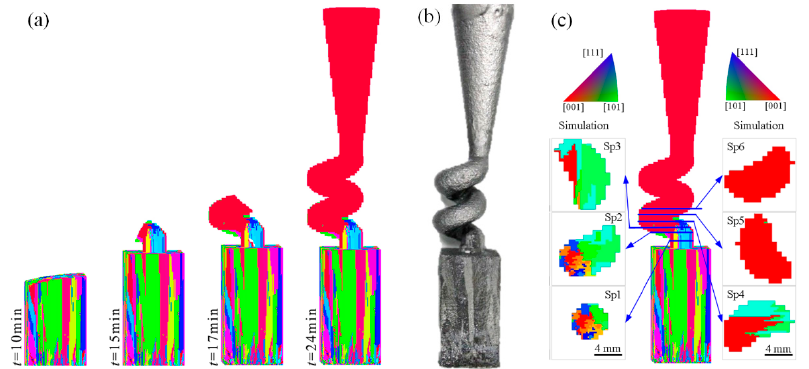
Figure 6. Comparison of grain growth in spiral part during experiment and simulation: ( a ) microstructure evolution simulation; ( b ) experimental result and ( c ) comparison of microstructure morphologies in different sections; structure of spiral part: d s = 6 mm and h s = 10.9 mm, θ = 30° and d w = 5 mm.